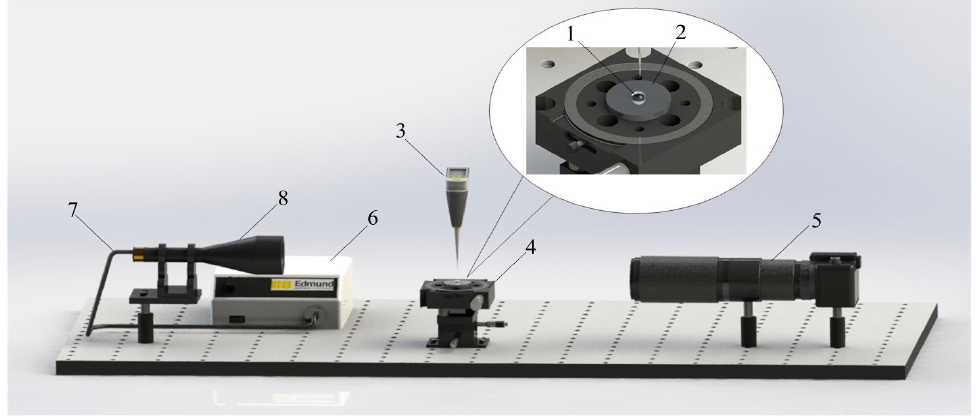
Figure 1. Experimental setup for measuring the static contact angles formed by liquid droplets and solid surfaces (AMG-6, PTFE): 1—liquid droplet; 2—AMG-6 or PTFE discs; 3—electronic dispenser;